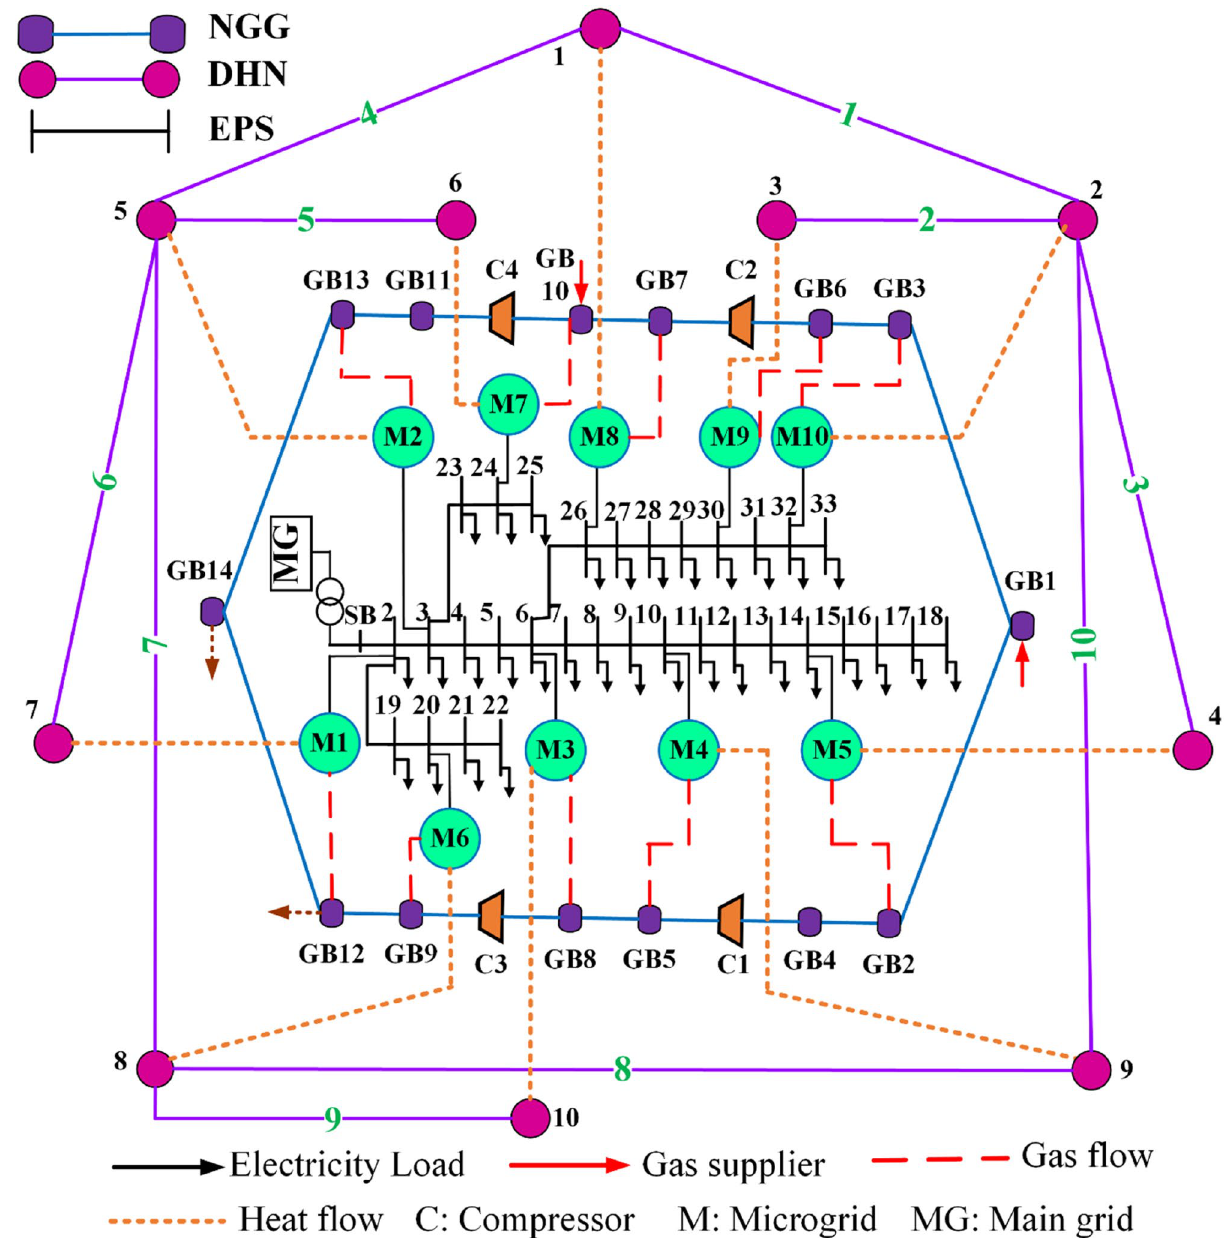
Figure 2. Schematic of the intended test system. The proposed system is the integrated structure of EPS, NGG, and DHN that offers a systematic area of model for facilitating multi-energy interactions in the local area of Chicago.